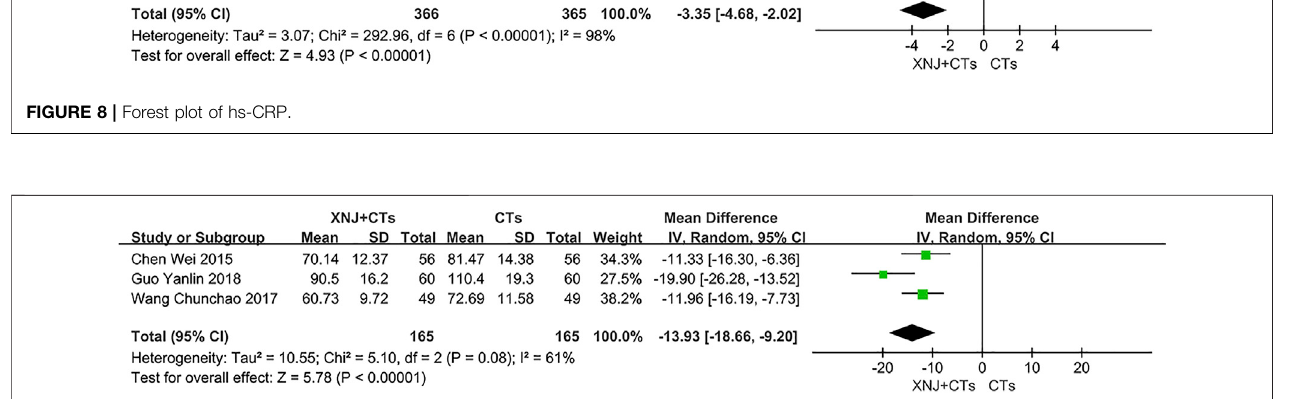
FIGURE 9 | Forest plot of MMP-9.